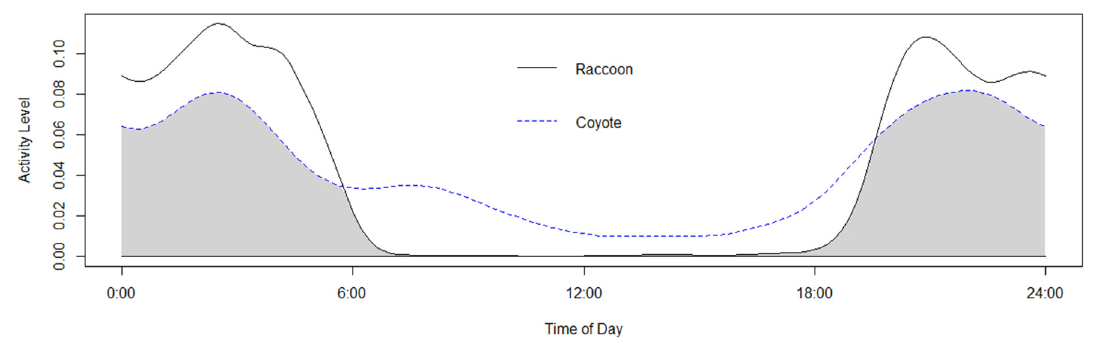
Figure 4. Daily activity patterns for raccoons (solid line) and coyotes (dashed line) at Fort Bragg Military Installation, North Carolina, USA. The coefficient of overlap ( Δ ; represented by the shaded area) was 0.75.